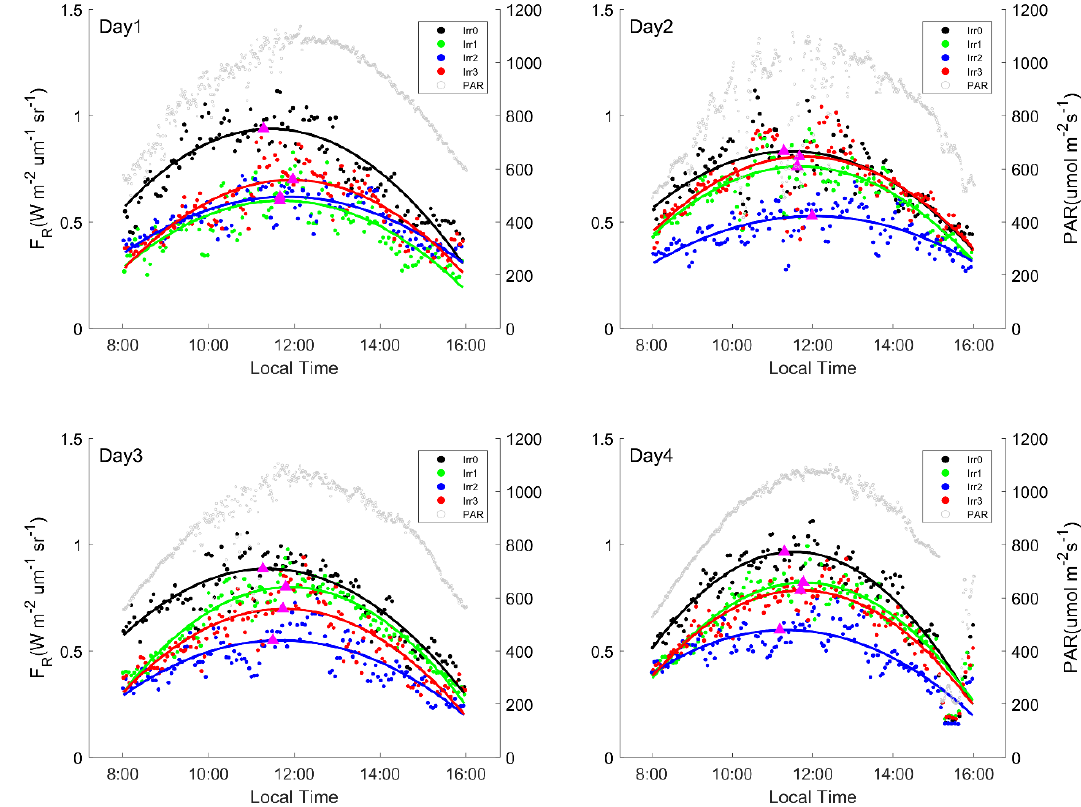
Figure 3. Diurnal red fluorescence (F R ) data, with Day1 to Day4 representing 4 observation dates (30 July, 31 July, 3 August, 4 August). Scatter points represent measured data, and solid line represents fitted data of SIF. Magenta triangles represents peak value of fitted data. On the evening of Day1, Irr1 and Irr3 were watered 0.3 m 3 and 0.16 m 3 , respectively. On the evening of Day3, Irr0, Irr1, Irr2, and Irr3 were watered 0.4 m 3 , 0.2 m 3 , 0.3 m 3 , and 0.16 m 3 , respectively.